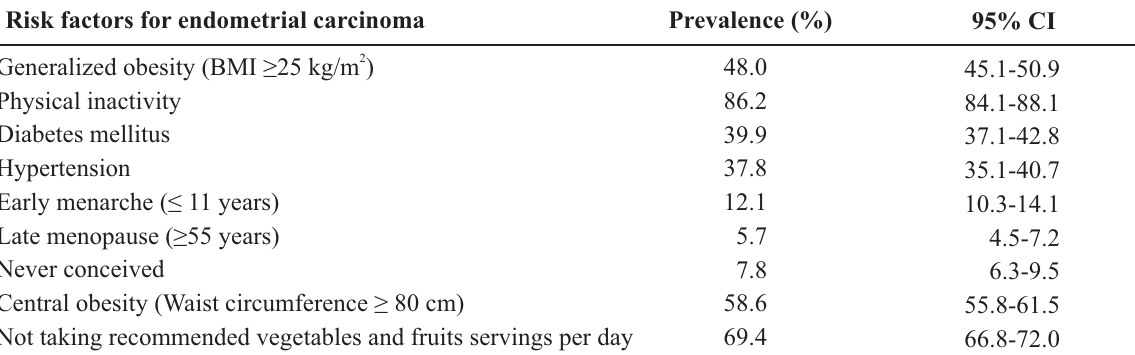
Table 5: Prevalence of selected risk factors for endometrial carcinoma